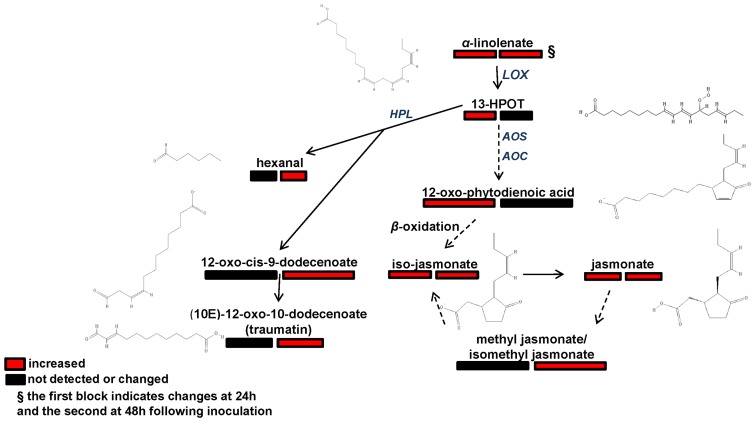
Fluctuations in the α-linolenate metabolism of soybean in response to Rhizoctonia solani at 24 h and 48 h post-inoculation coded using a color code based on P-values (P<0.05) performing the Student's t-test or means of scaled and centered PLS regression coefficients (CoeffCS) from five biological replications and a quality control sample per treatment.Genes in the reference pathway of KEGG for soybean that are hyperlinked to gene entries are displayed. Dashed lines symbolize multi-step or not fully elucidated reactions and solid lines one-step reactions [13-HPOT; (9Z,11E,15Z)-(13S)-hydroperoxyoctadeca-9,11,15-trienoate, AOC; allene oxide cyclase, EC: 5.3.99.6, NCBI-GeneID:100800036, AOS; hydroperoxidedehydratase, EC: 4.2.1.92, NCBI-GeneID: 100037481, HPL; hydroperoxidelyase, EC: 4.1.2.-, NCBI-GeneID: 100784395, LOX; lipoxygenase, EC: 1.13.11.12, NCBI-GeneID: 100785480].